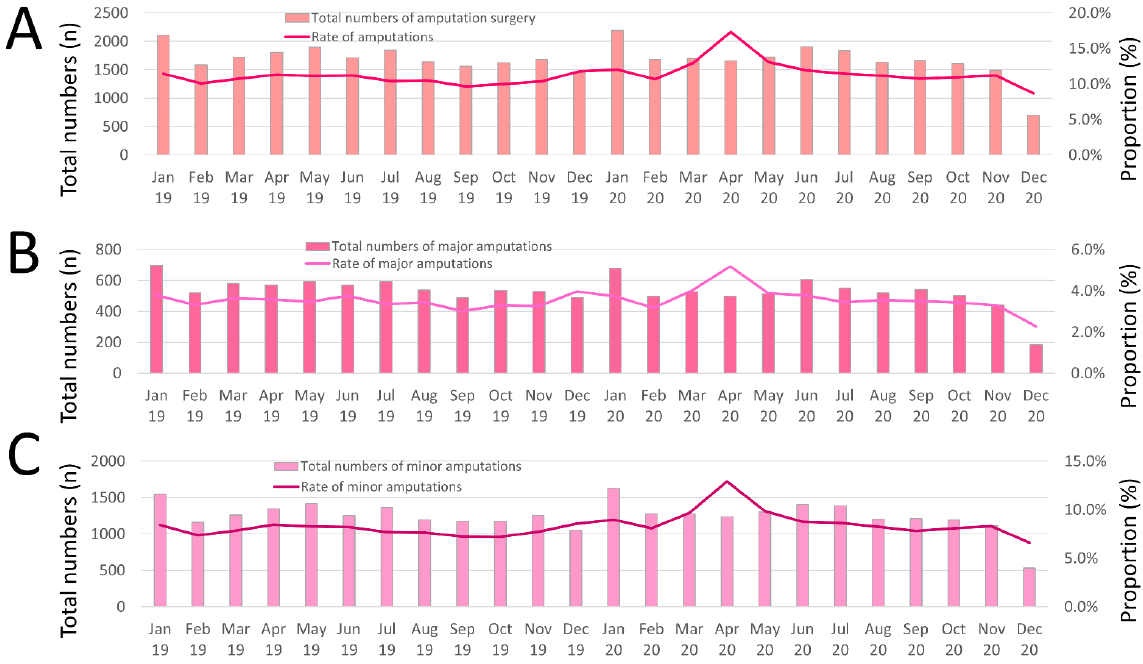
Figure 3. Temporal trends regarding absolute numbers of hospitalizations due to PAD and amputation surgery. ( A ) Temporal trends regarding absolute numbers of hospitalizations of PAD patients with amputation surgeries (red bars), and proportion of amputation treatment related to all hospitalizations of PAD patients (red line) stratified for treatment month. ( B ) Temporal trends regarding absolute numbers of hospitalizations of PAD patients with major amputation surgeries (red bars), and proportion of major amputation treatment related to all hospitalizations of PAD patients (violet line) stratified for treatment month. ( C ) Temporal trends regarding absolute numbers of hospitalizations of PAD patients with minor amputation surgeries (pink bars), and proportion of minor amputation treatment related to all hospitalizations of PAD patients (violet line) stratified for treatment month.